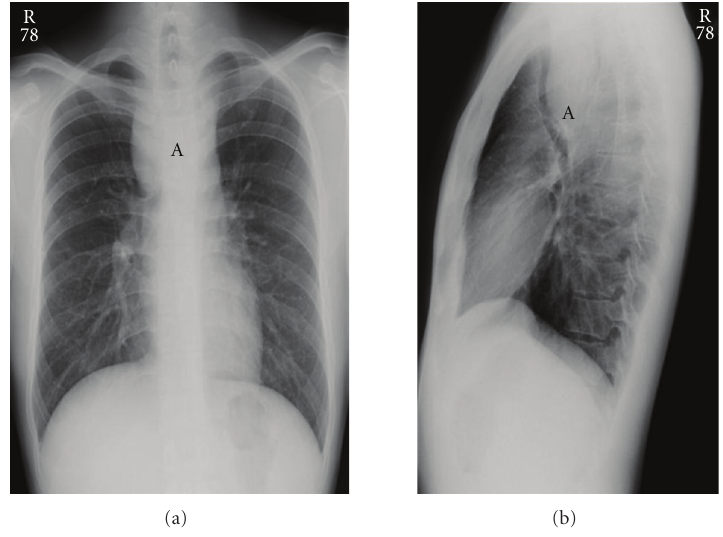
Figure 1: Chest X-ray AP (a) and lateral (b) views showing a large mediastinal mass (A).